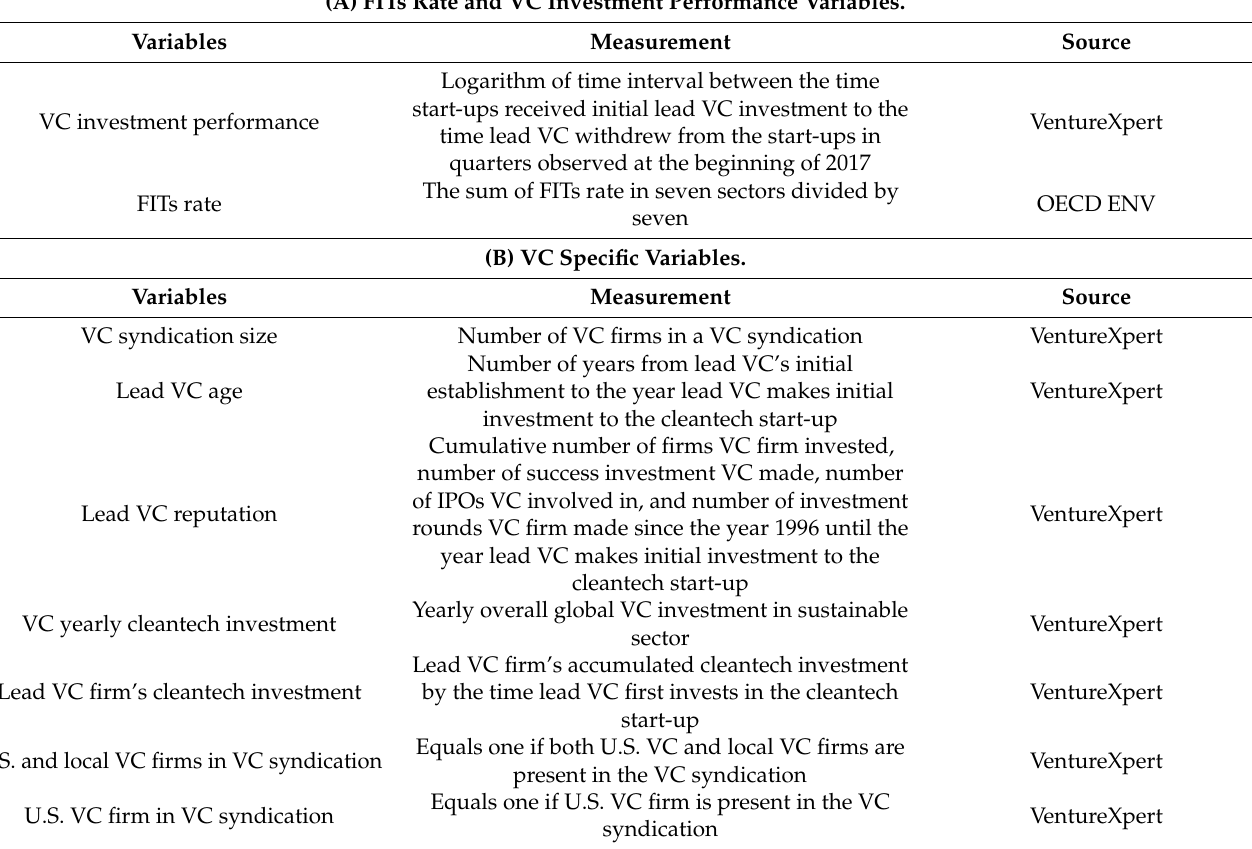
Table 2. Variable measurements and